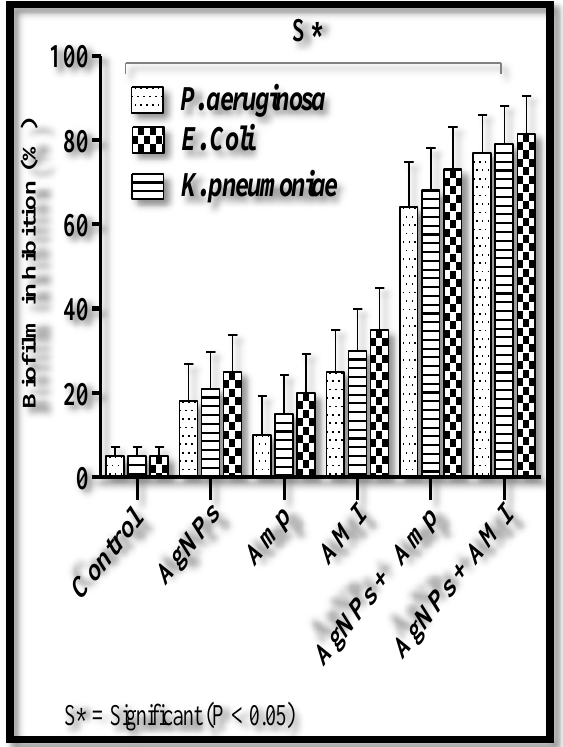
Figure 6. ant-biofilm inhibitory activity of AgNPs alone and in combination with